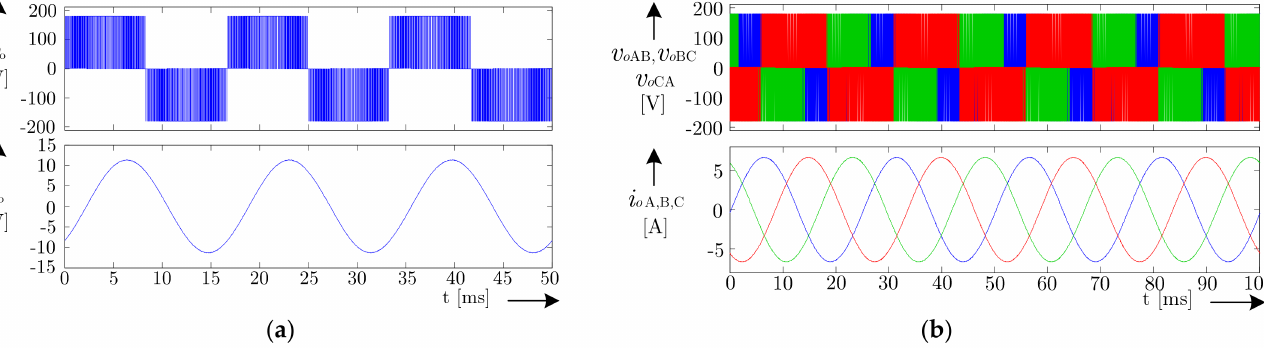
Figure 12. Simulated results of voltage and load current at the output of the inverter with open loop SPWM and in steady state; ( a ) single-phase FB VSI; ( b ) three-phase